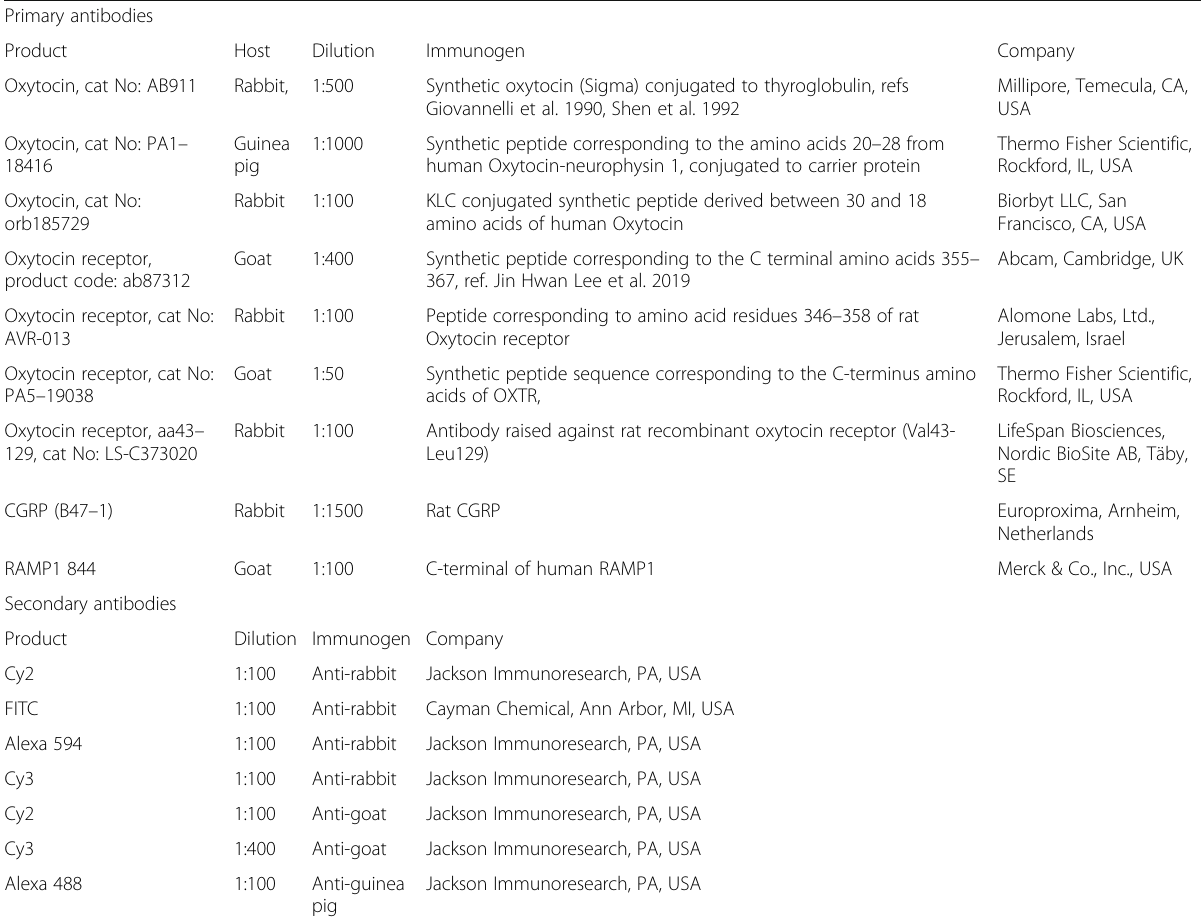
Table 1 Details of the primary and secondary antibodies Primary